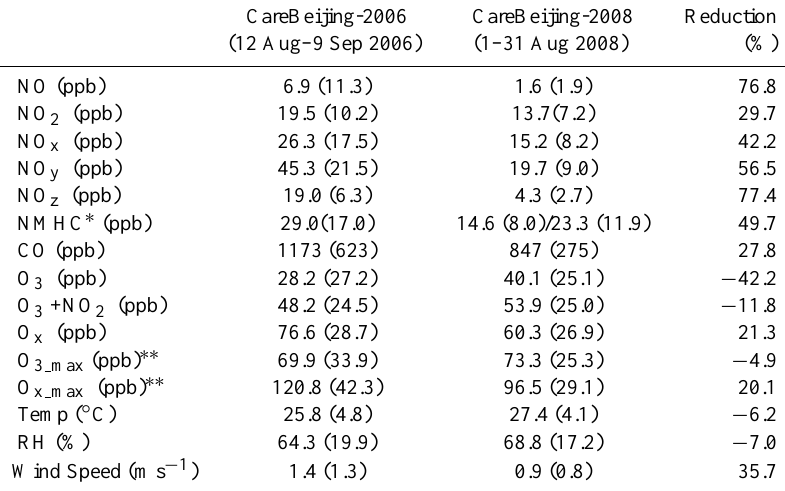
Table 2. Statistics of the ambient levels of trace gases and meteorological parameters measured in Beijing during CAREBeijing-2006 and CAREBeijing-2008. The standard deviation of each mean value is noted in the